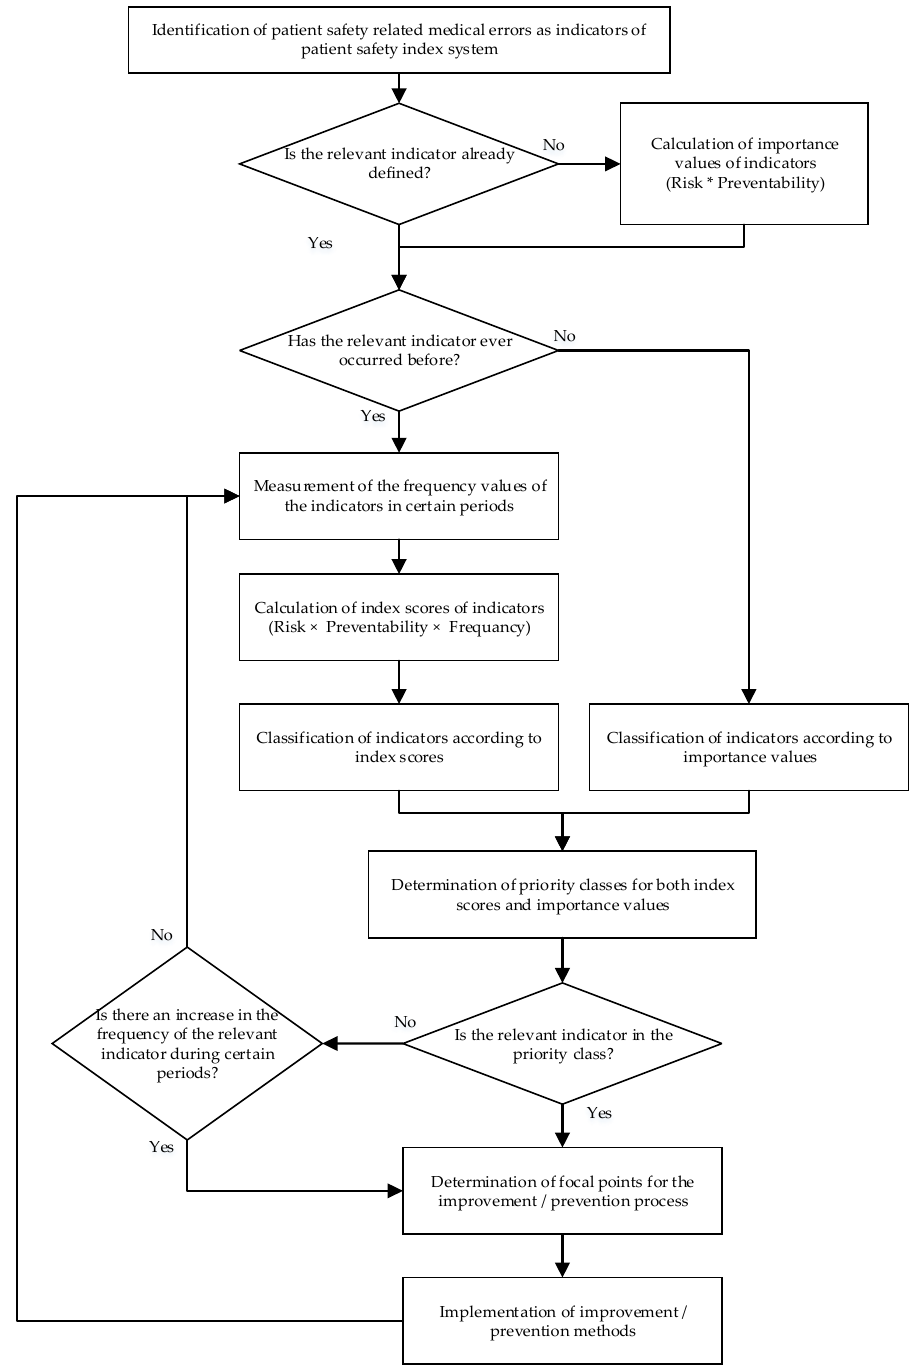
Figure 1. Proposed Patient Safety Index Methodology.